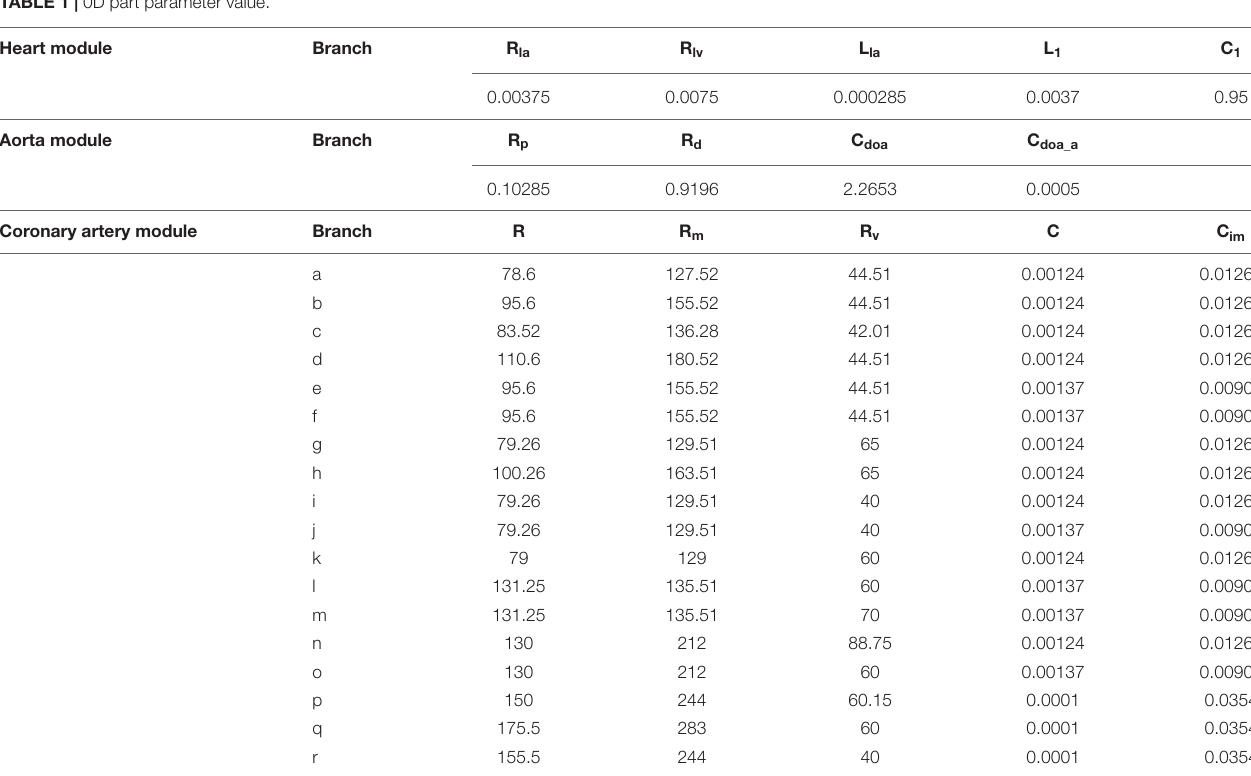
TABLE 1 | 0D part parameter